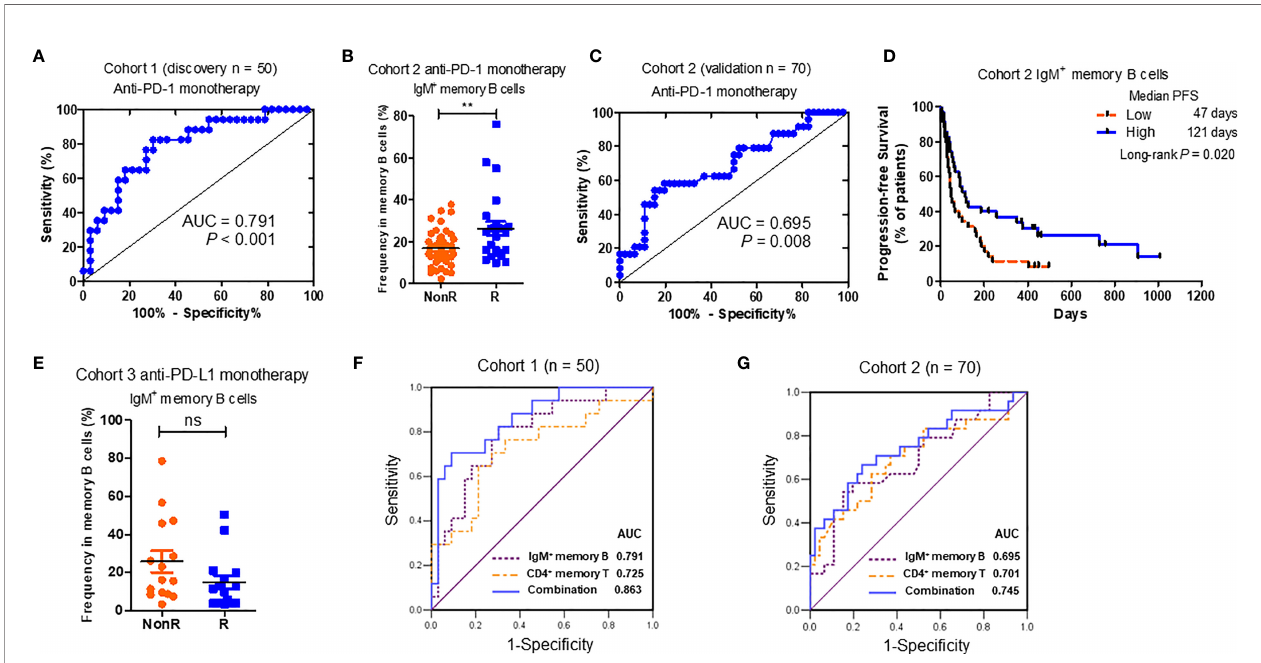
FIGURE 4 | Signi fi cance of baseline IgM + memory B cells in predicting the response to anti-PD-1 monotherapy. (A) The Receiver Operating Characteristic (ROC) analyses of IgM + memory B cell percentages in discovery cohort (cohort 1 in Table 1 , n = 50). (B) Comparison of the percentages of IgM + memory B cells between R (n = 24) and NonR (n = 46) advanced NSCLC patients with anti-PD-1 monotherapy in an independent validation cohort (cohort 2 in Table 1 , n = 70). (C) The ROC analysis of IgM + memory B cell percentages in validation cohort (cohort 2 in Table 1 , n = 70). (D) The Kaplan-Meier analysis of the associations of the percentages of IgM + memory B cells with the PFS in cohort 2. (E) Comparison of the percentages of IgM + memory B cells between R (n = 15) and NonR (n = 15) advanced NSCLC patients with anti-PD-L1 monotherapy in an independent validation cohort (cohort 3 in Table 1 , n = 30). (F, G) The ROC analyses of baseline CD19 + memory B combined with CD4 + memory T cell percentages in discovery cohort 1 (F) and validation cohort 2 (G) . The Wilcoxon test was used to analyze the differences between two groups. Survival curves were plotted by using the Kaplan-Meier method using median as the cutoff to de fi ne the high and low group. P - values were calculated by the log-rank statistics in Kaplan-Meier analyses. ** P < 0.01, ns, P >